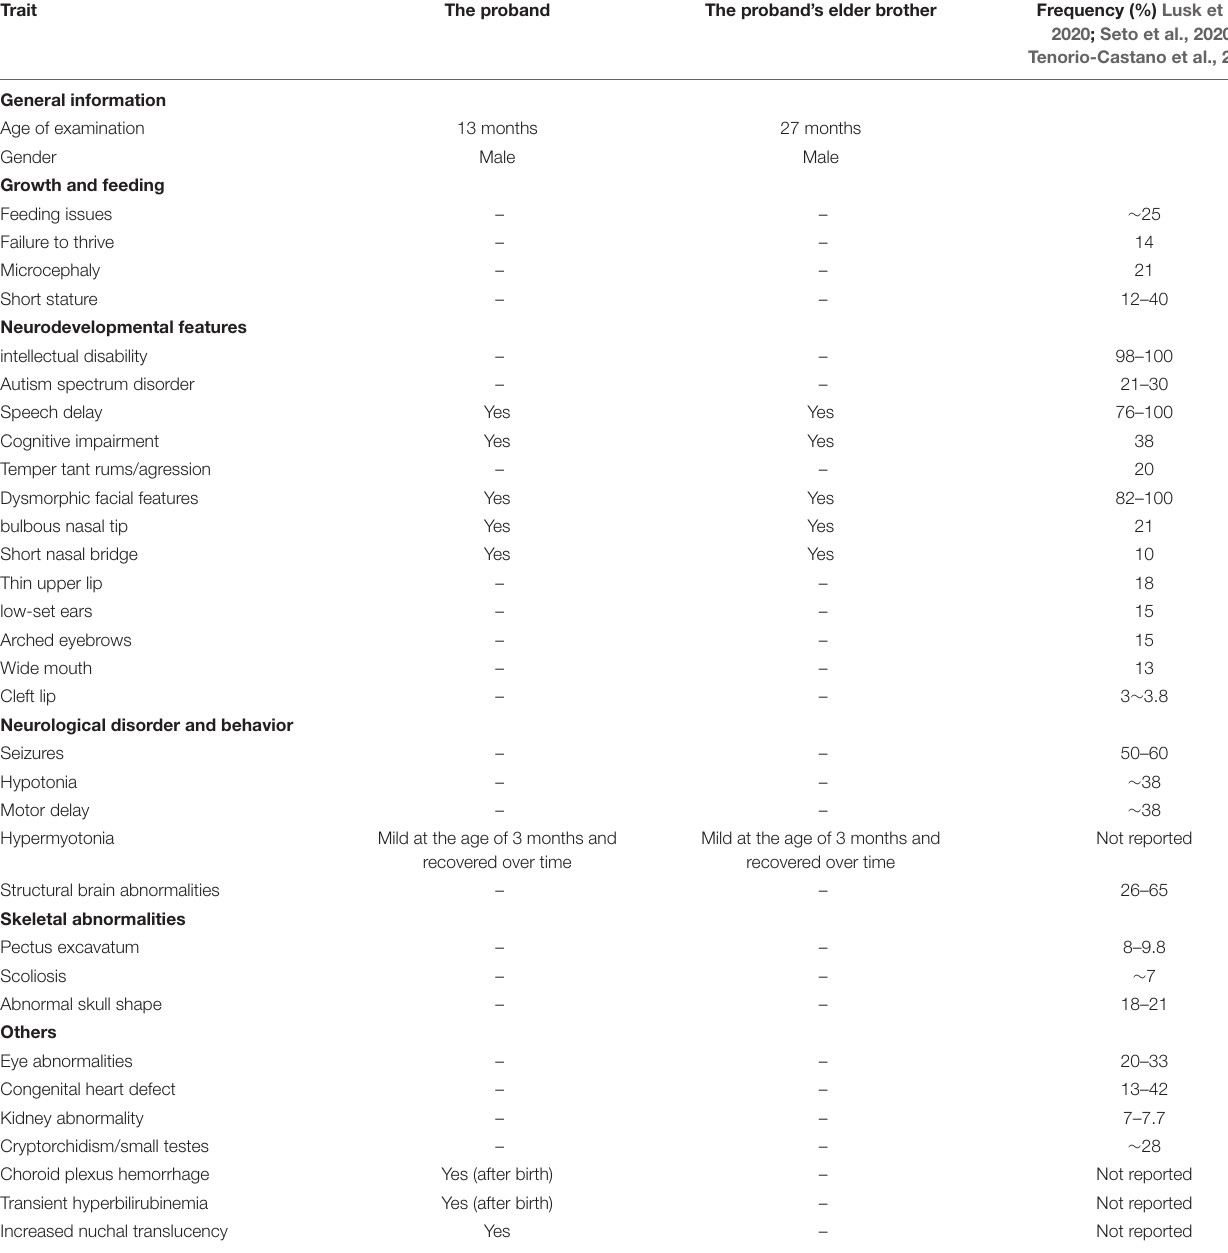
TABLE 1 | Summary of the clinical features of our patients and the list of reported frequency in patient with